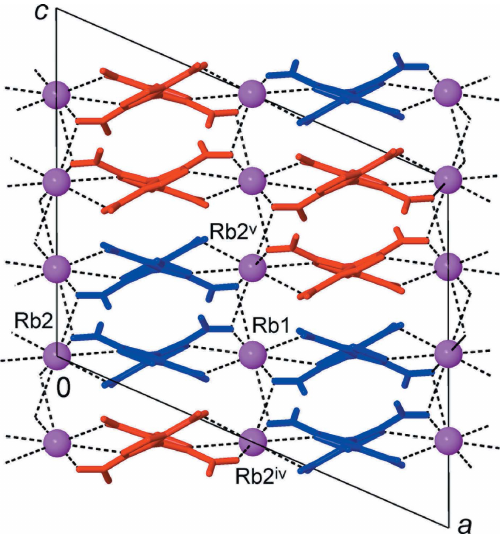
Figure 5 Structure of ( 1 ) viewed in projection on the ac plane (down the direction of the anionic chains) showing the organic layers, which are separated by layers of the cations. The chains of opposite polarity are identified by blue and red colors. [Symmetry codes: (iv) x (cid:3) 1 (cid:3) z + 1